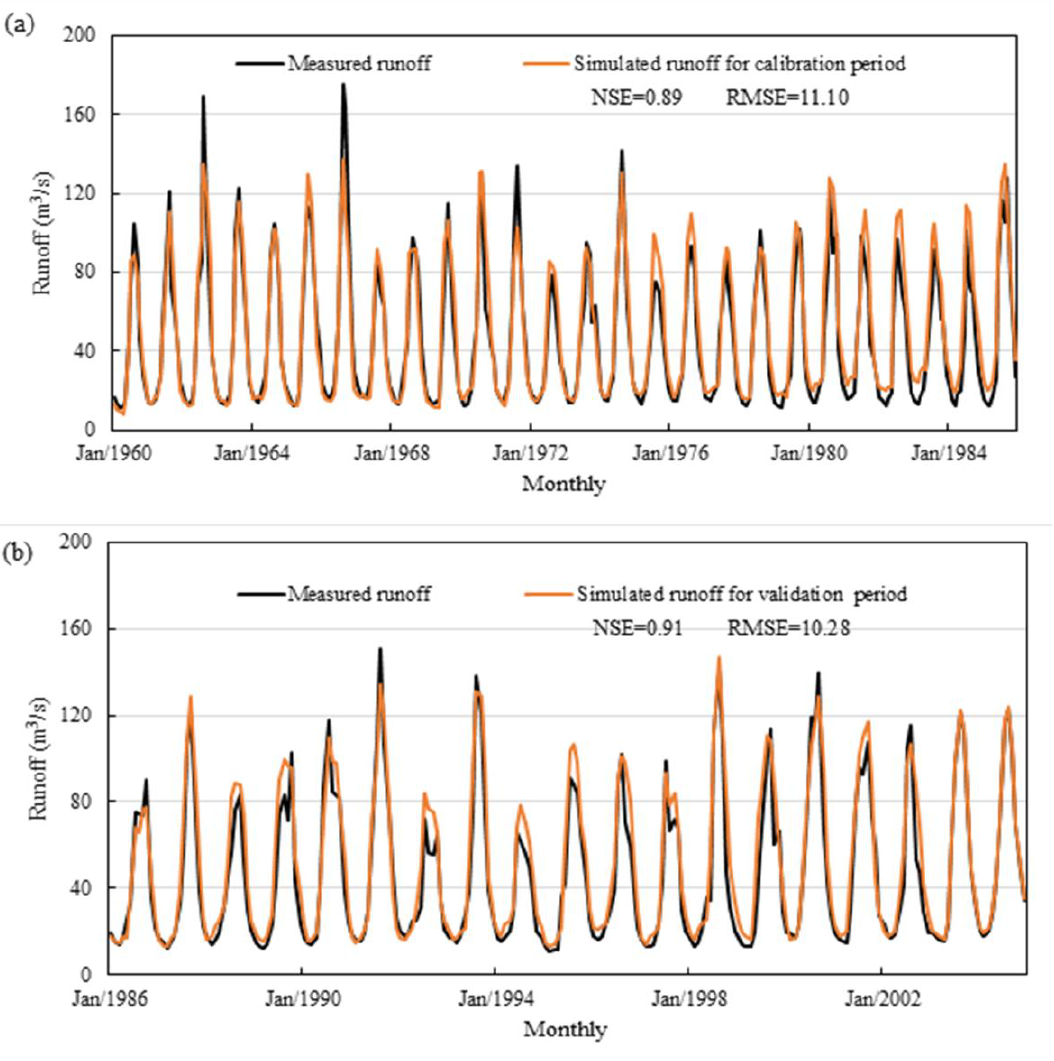
Figure 6. Simulated runoff based on the TOPMODEL model. ( a ) Calibration period and ( b ) validation period . Table 2. Weight for each single model (%).